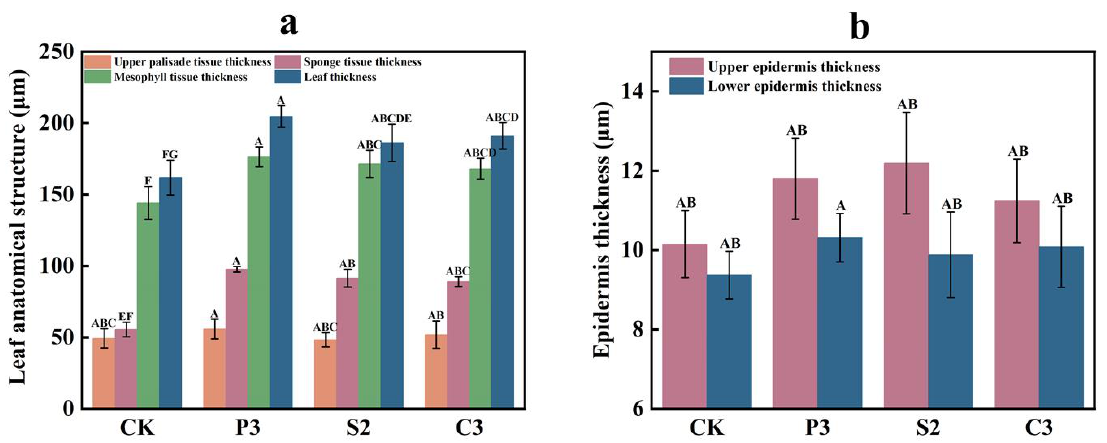
Figure 5. Effect of PGRs on anatomical structure of leaves of M. alternifolia . ( a ) Upper palisade tissue thickness, sponge tissue thickness, mesophyll tissue thickness, and leaf thickness, ( b ) upper epidermis thickness and lower epidermis thickness. Note: different letters followed the mean indicate significance at p < 0.01 according to Duncan’s multiple range test.